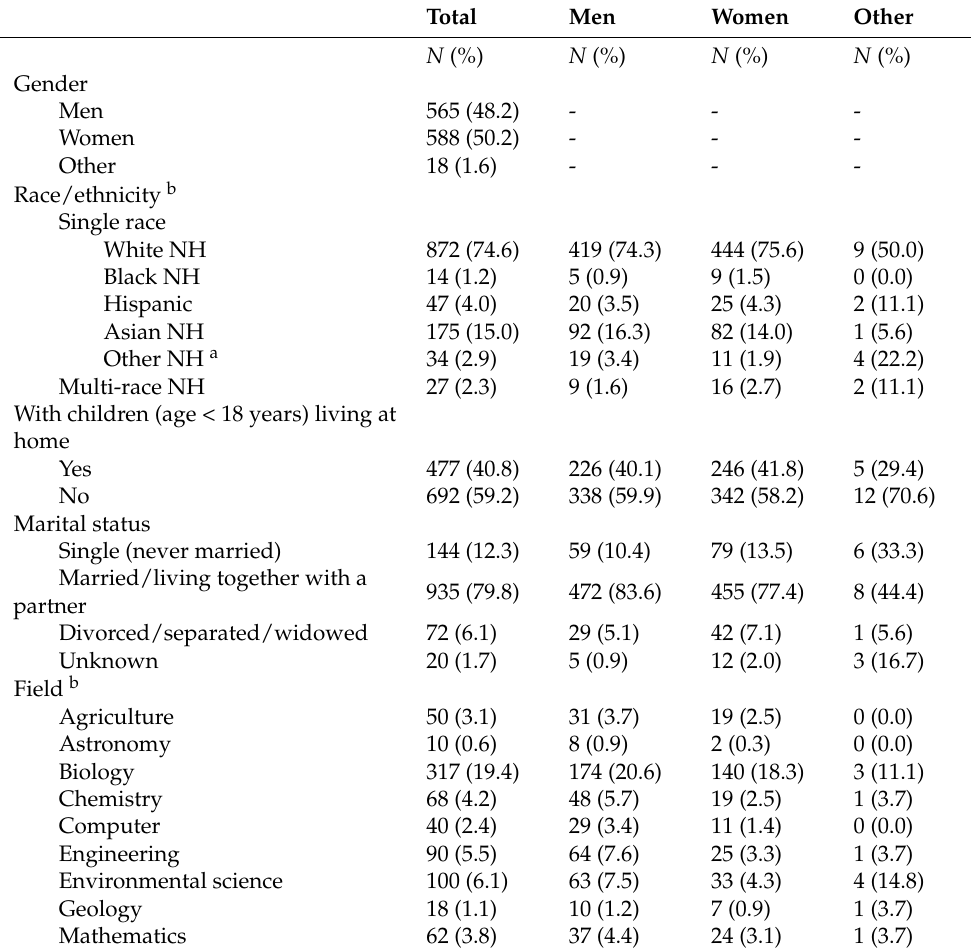
Table 1. Characteristics of survey participants ( N =